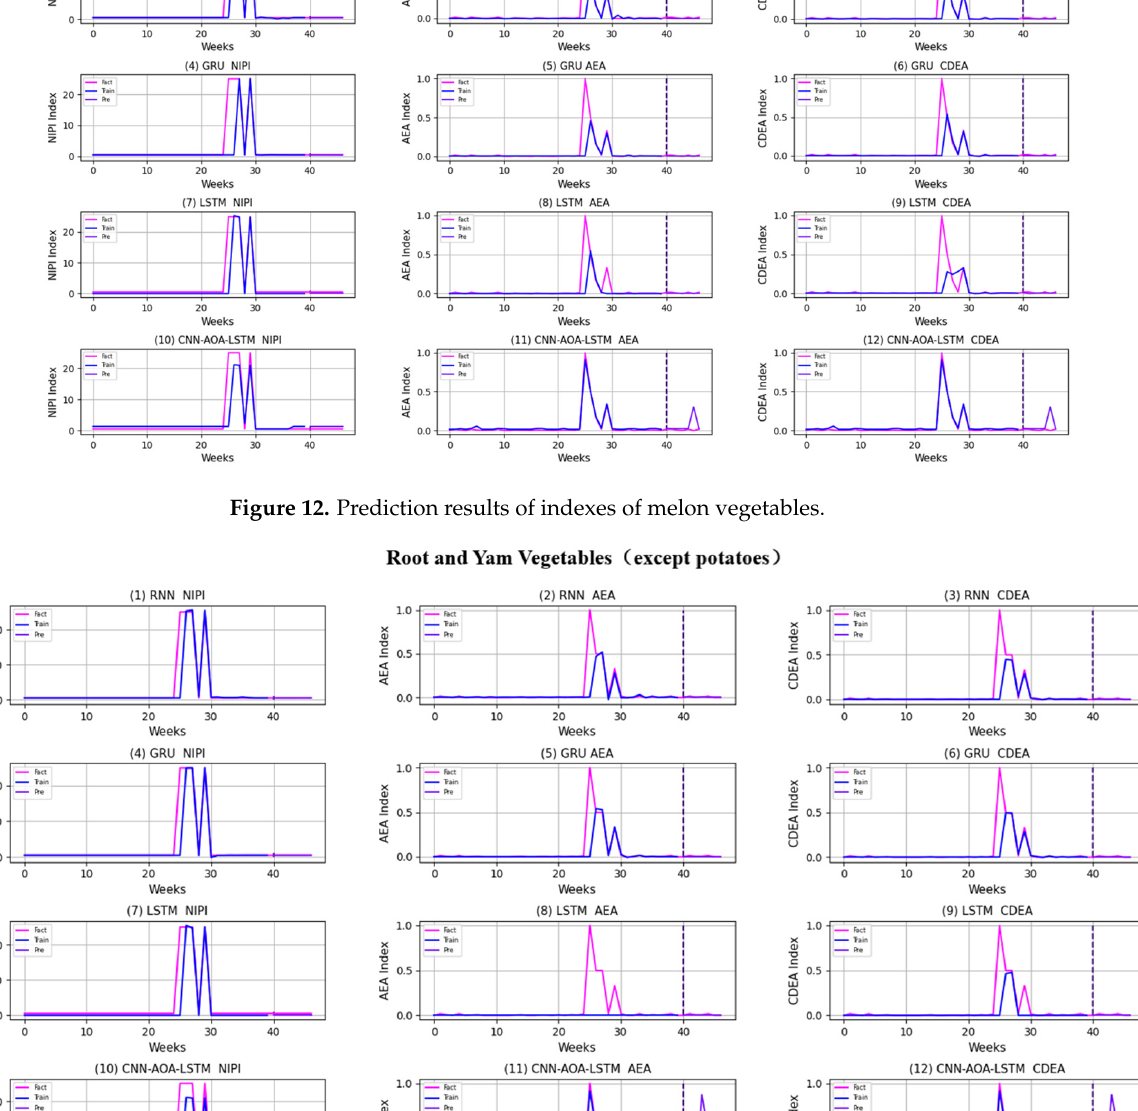
Figure 13. Prediction results of indexes of root and yam vegetables (except potatoes).